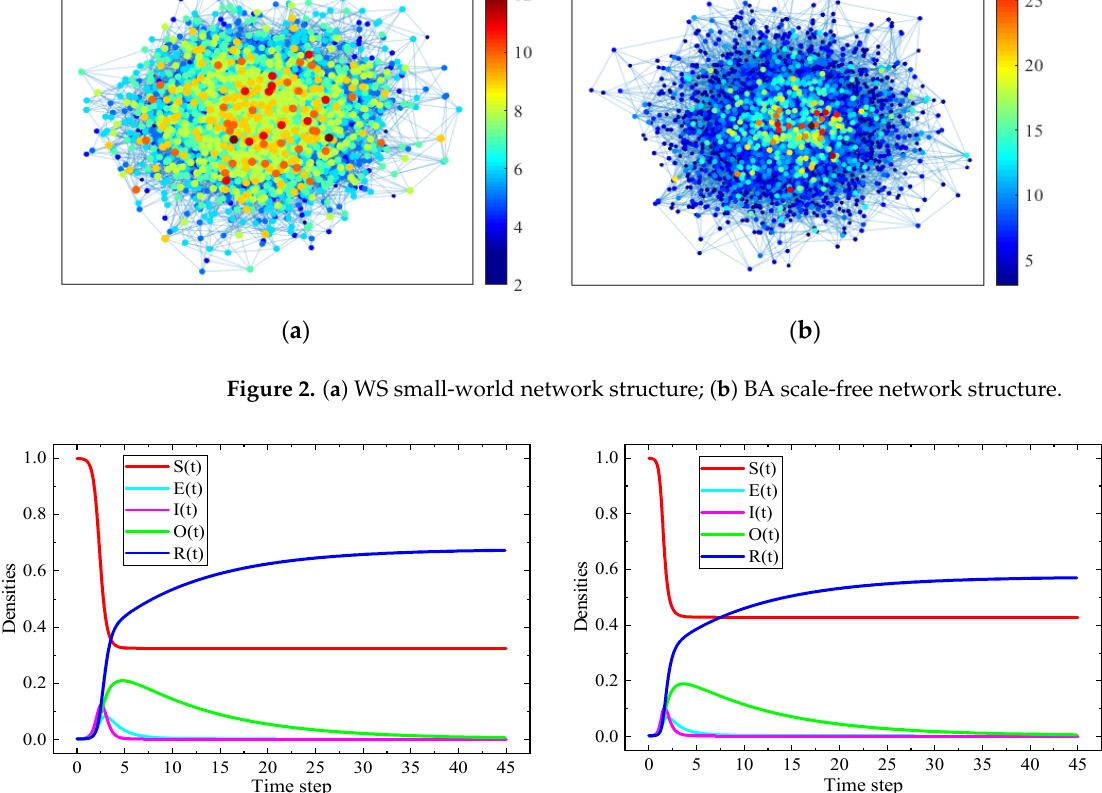
Table 2. Model parameter settings during Monte–Carlo simulation.